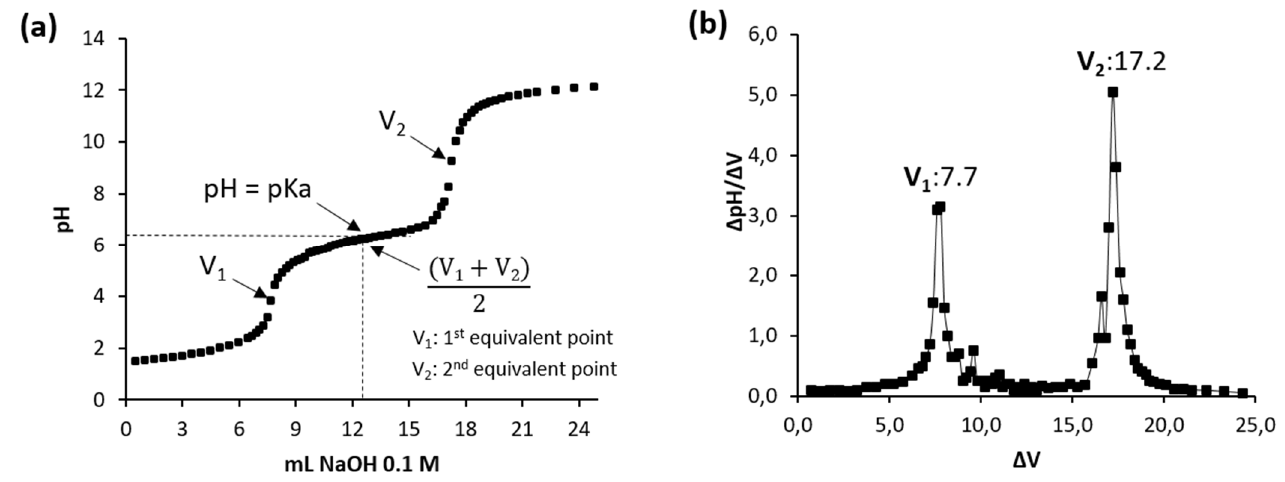
Figure 2. ( a ) Potentiometric titration of Chitosan-CGNA at pH 1.0–12.0; ( b ) first derivative curve of potentiometric trita- tion.